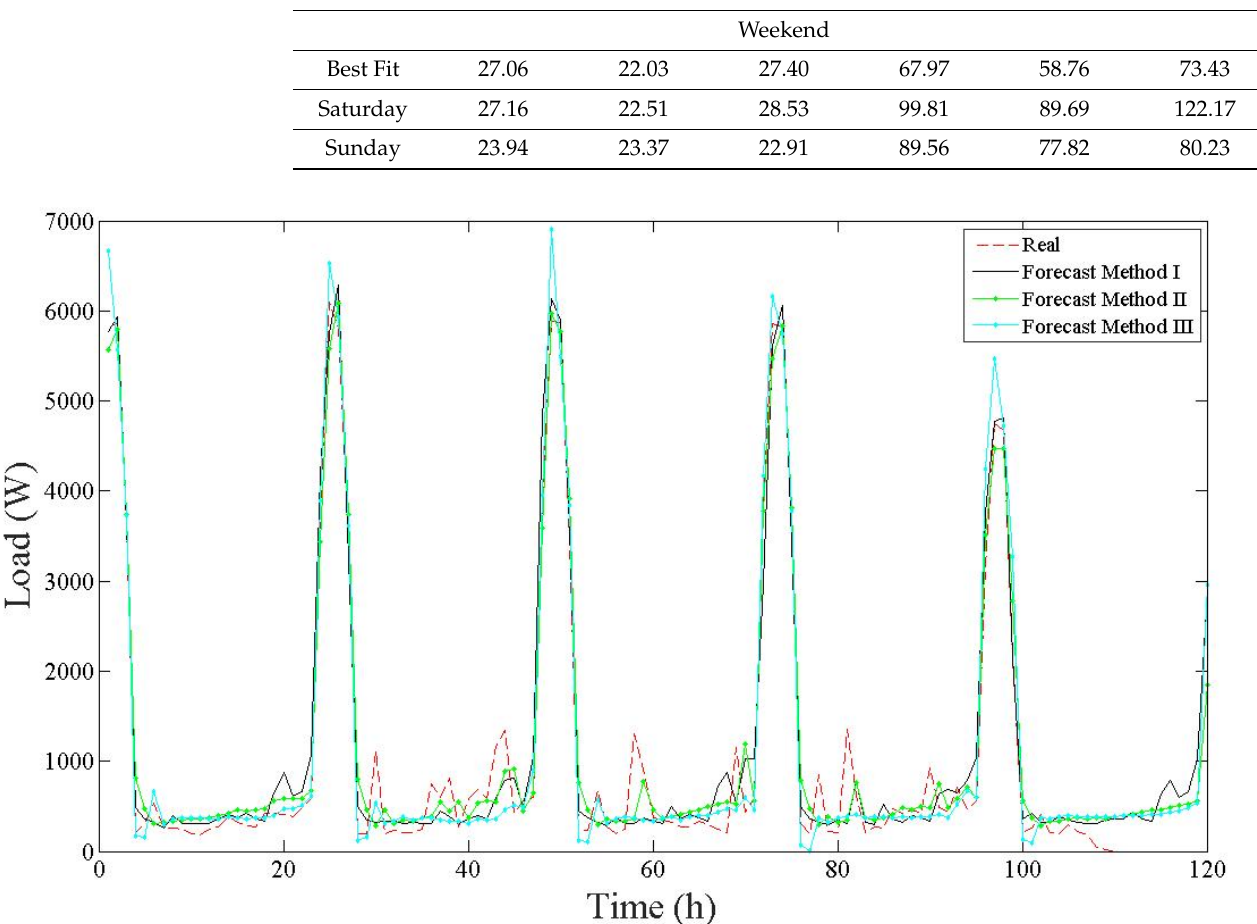
Figure 8. Forecast hourly load of working days of household No 73. In both, the three methods confirm an acceptable error for similar forecasting.